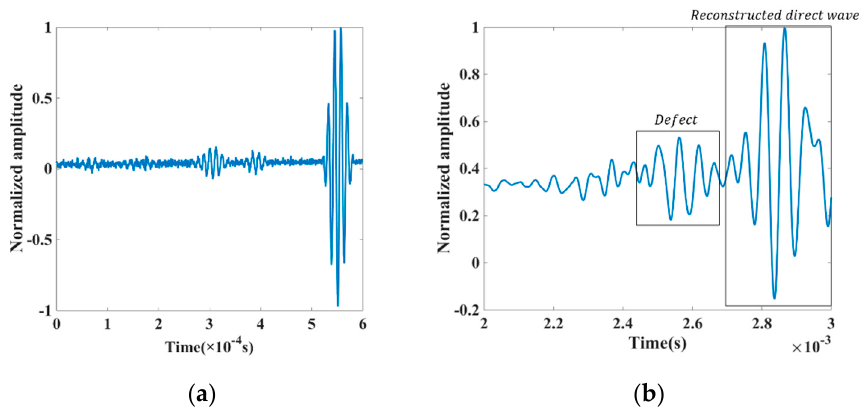
Figure 10. The signal reserved in the time domain in piezoceramic transducers. ( a ) The time-reversal signals ( b ) Results of the reversal progress.